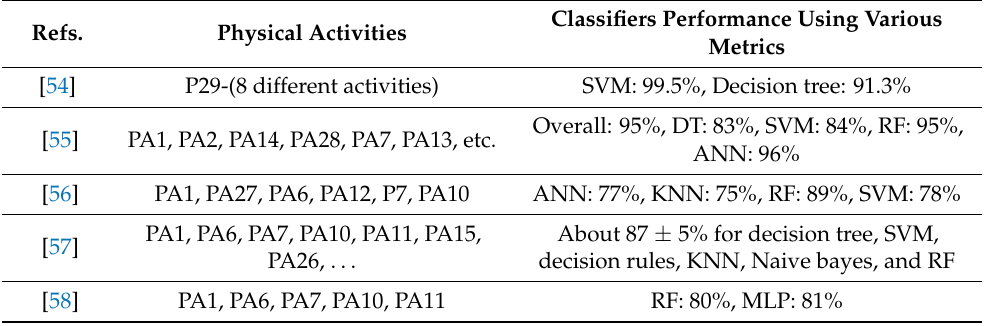
Table 3. Literature summary of classifiers performance comparison for various physical activities.